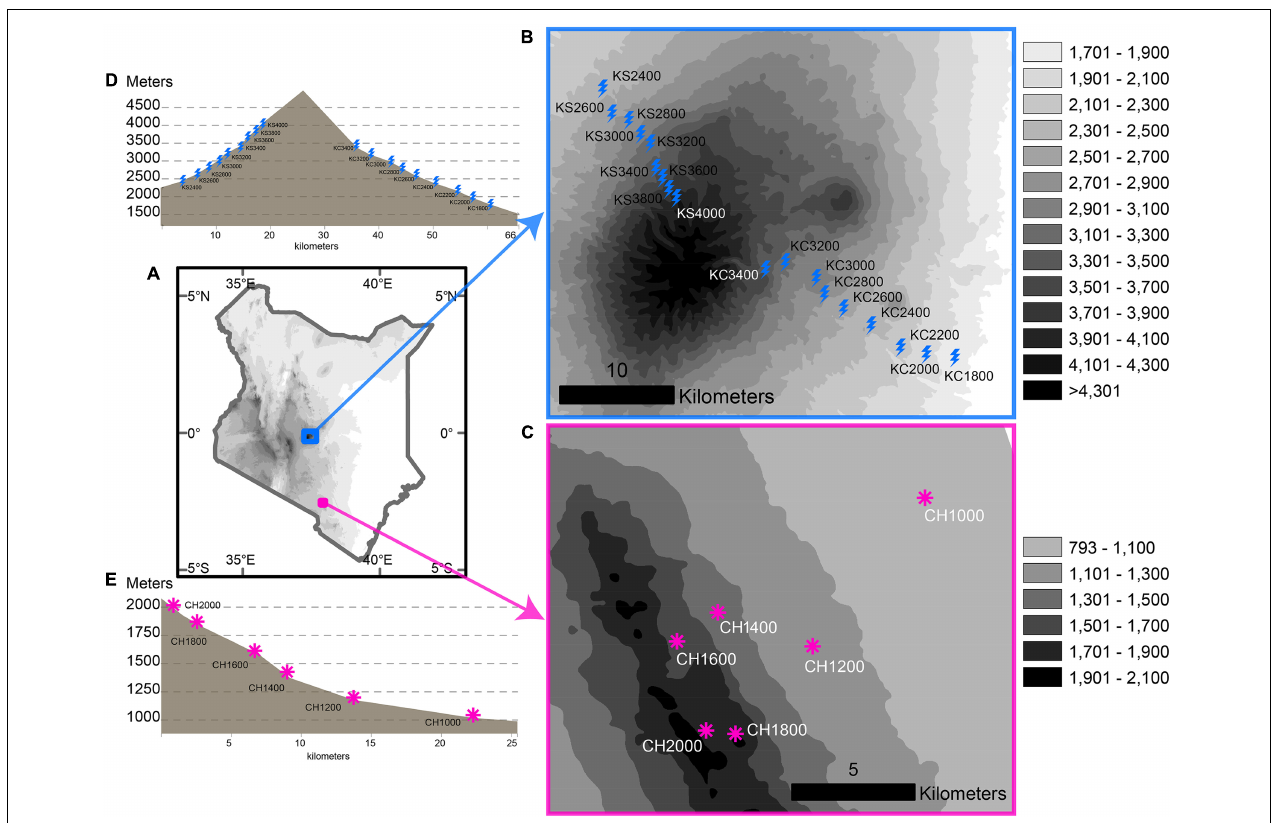
FIGURE 1 | Study area and field sampling design of this study. (A) Map of Kenya showing the location of Mount Kenya and Chyulu; (B,C) Sampled elevational transects in Mt. Kenya and Chyulu, respectively. (D,E) Vertical elevational profile vs. distance along the Mt. Kenya and Chyulu transects,